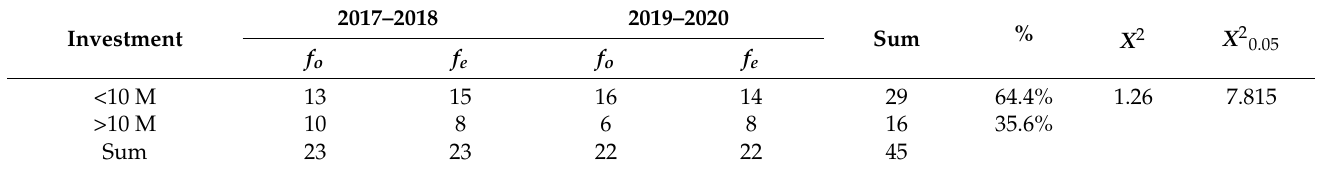
Table 5. Temporal evolution of the intention of buying electric buses by